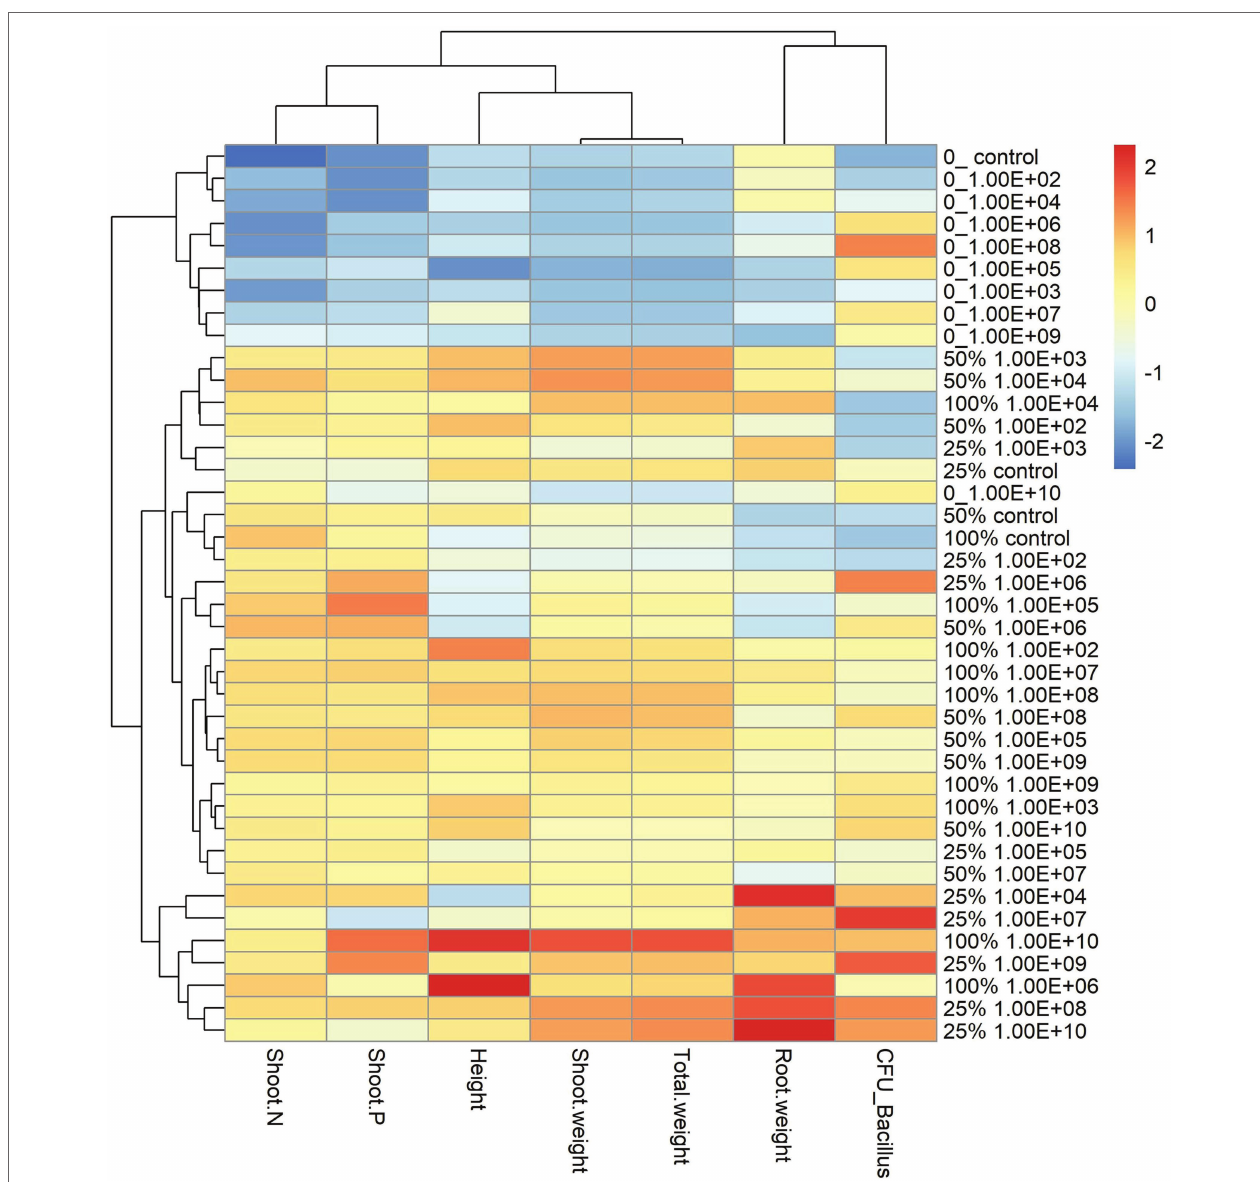
FIGURE 3 | Heatmap with cluster analysis. The column corresponds to inoculation concentrations and mineral fertilization doses and the line to the biometric parameters of the soybean plant. The Y-axis—0_ indicates the fertilization dose, and 1.00E+02 indicates the inoculum concentration. The fertilization doses were 0%, 25%, 50% and 100%, and the fertilization doses were 1 × 10 2 CFU ml − 1 , 1 × 10 3 CFU ml − 1 , 1 × 10 4 CFU ml − 1 , 1 × 10 5 CFU ml − 1 , 1 × 10 6 CFU ml − 1 , 1 × 10 7 CFU ml − 1 , 1 × 10 8 CFU ml − 1 , 1 × 10 9 CFU ml − 1 , and 1 × 10 10 CFU ml − 1 , representing 1.00E+02, 1.00E+03, 1.00E+04, 1.00E+05, 1.00E+06, 1.00E+07, 1.00E+08, 1.00E+09, and 1.00E+10, respectively. The X-axis indicates the parameters of plant growth—total weight (g); shoot weight (g); height (cm); shoot P—phosphorus content in shoot g kg − 1 ; shoot N—nitrogen content in shoot g kg − 1 ; CFU_ Bacillus—amount of Bacillus reisolated from root CFU g − 1 and root weight